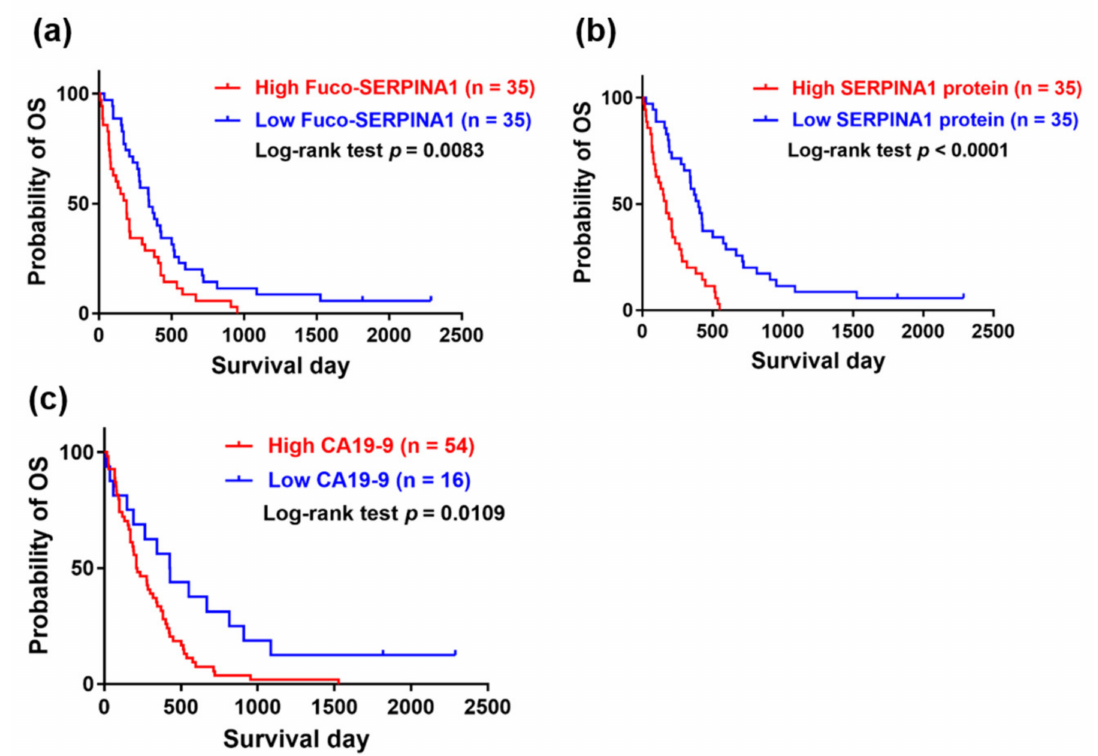
Figure 8. Association between overall survival of PC patients and plasma levels of fuco-SERPINA1 ( a ), SERPINA1 ( b ) and CA19-9 ( c ) analyzed using Kaplan–Meier plot. The time of survival was assessed in 68 of 71 PC patients enrolled in this study. The log-rank test p -value is denoted in each